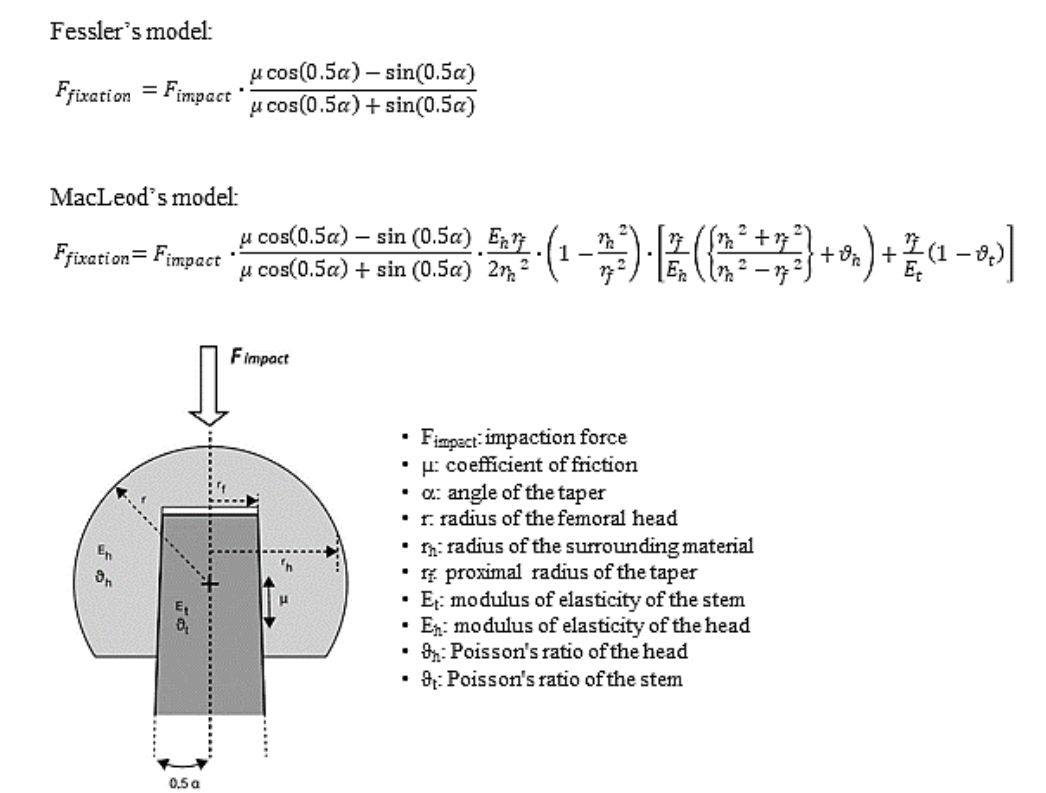
Figure 1. Fessler and MacLeod’s formulas illustrated. MacLeod’s model uses the same fundamental formula as Fessler’s model, as illustrated in the figure, but adds three factors that consider the geometry and the material properties of the system. In both models, the fixation force correlates linearly with the force applied to impact the taper. The effects of the other parameters are illustrated in Figures 2 – 4.